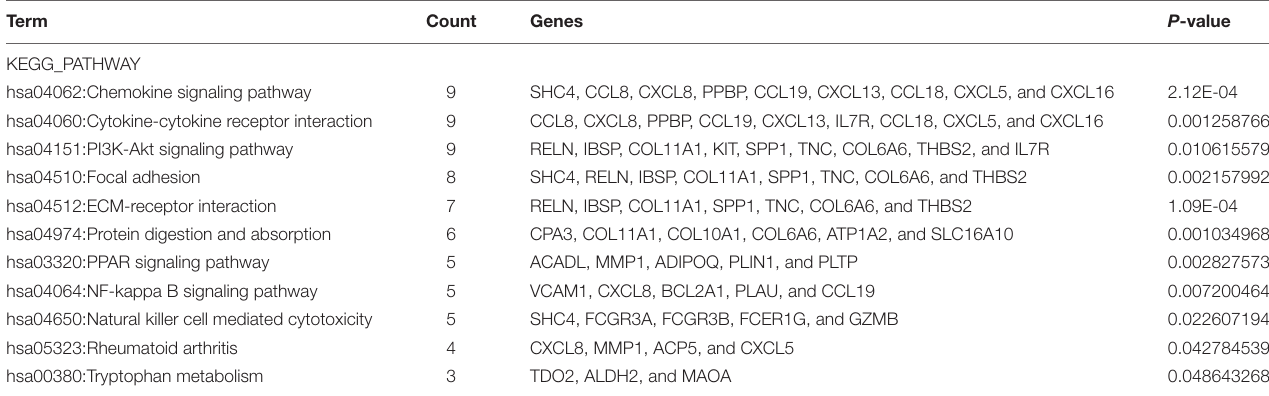
TABLE 2 | The KEGG pathway analysis of DEGs ranked by count. Term Count Genes P